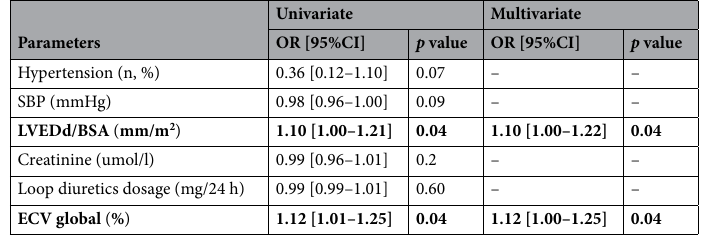
Table 3. Uni- and multivariate regression models for arrhythmic burden presence. OR odds ratio; CI confidence interval; other abbreviations as in Tables 1 and 2.